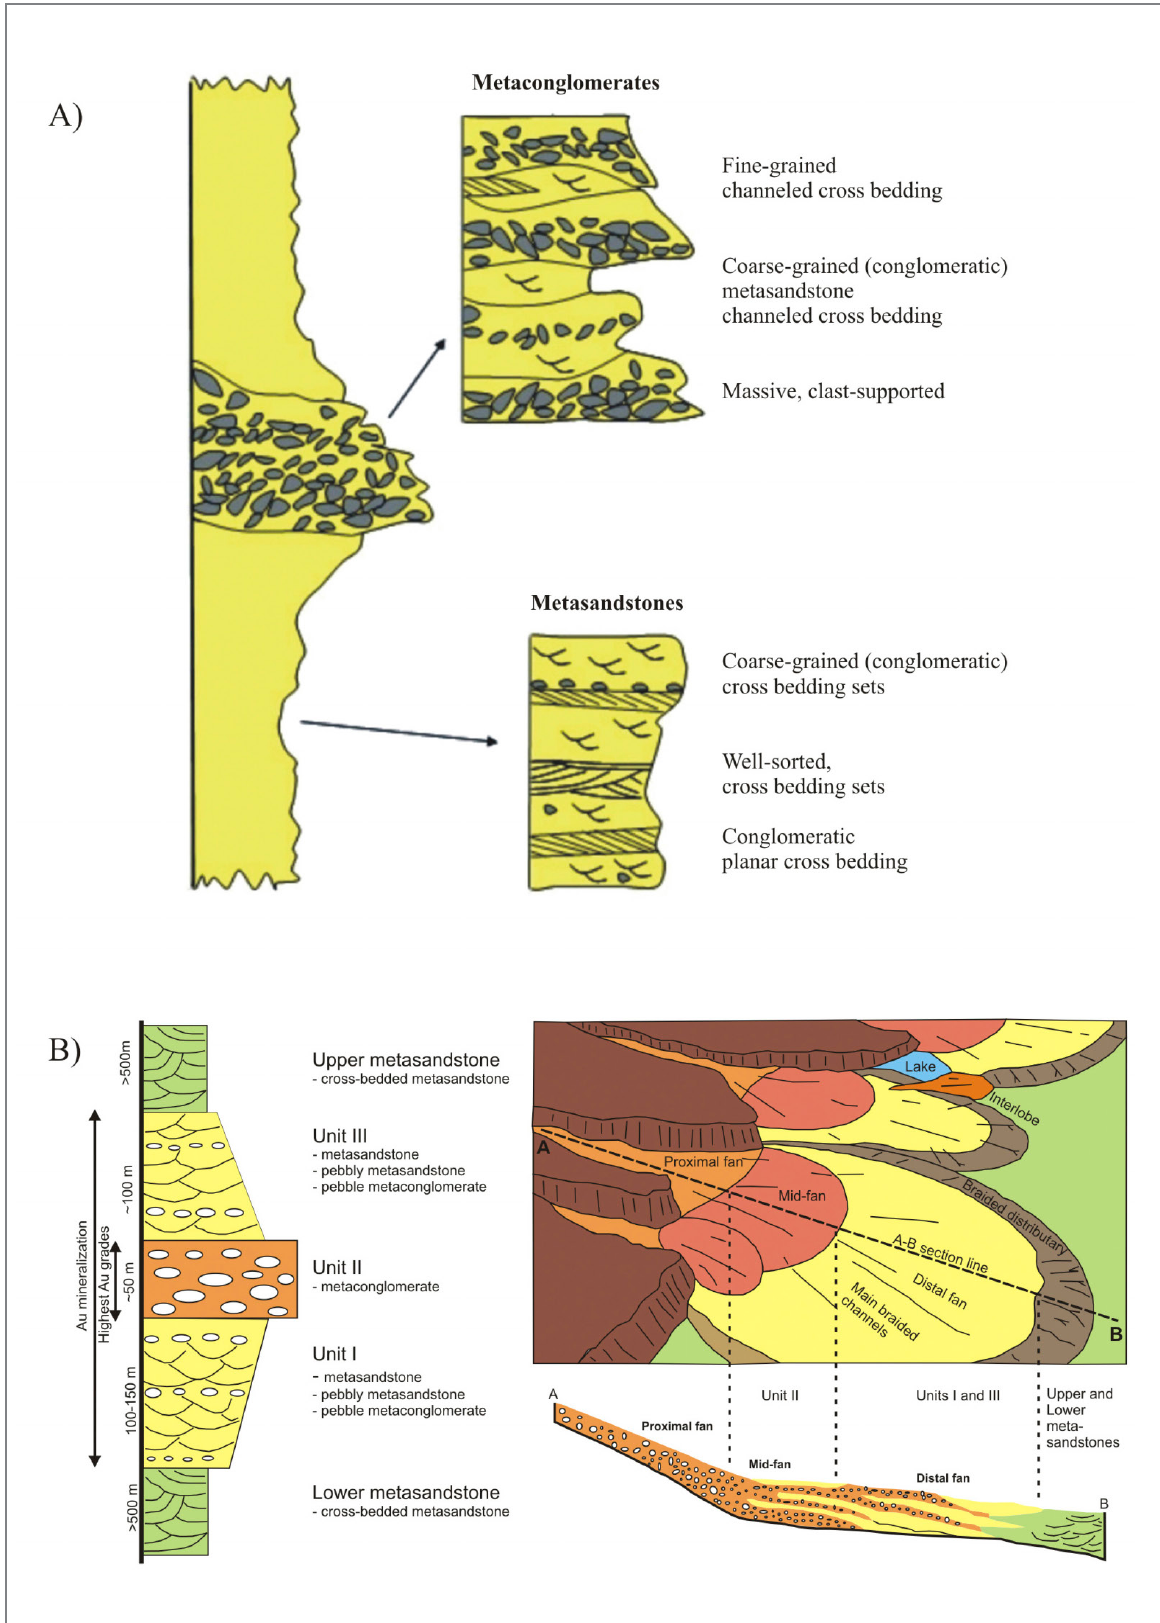
Figure 4 – (A) Simplified, not to scale, sedimentary section of the Castelo dos Sonhos Formation (adapted from Alkmin 2011). (B) Schematic section of part of the Castelo dos Sonhos Formation, with a more detailed subdivision of the central metaconglomerate layer and interpretation of the sedimentary setting (adapted from Karpeta 2016 apud Vargas and Campbell-Hicks